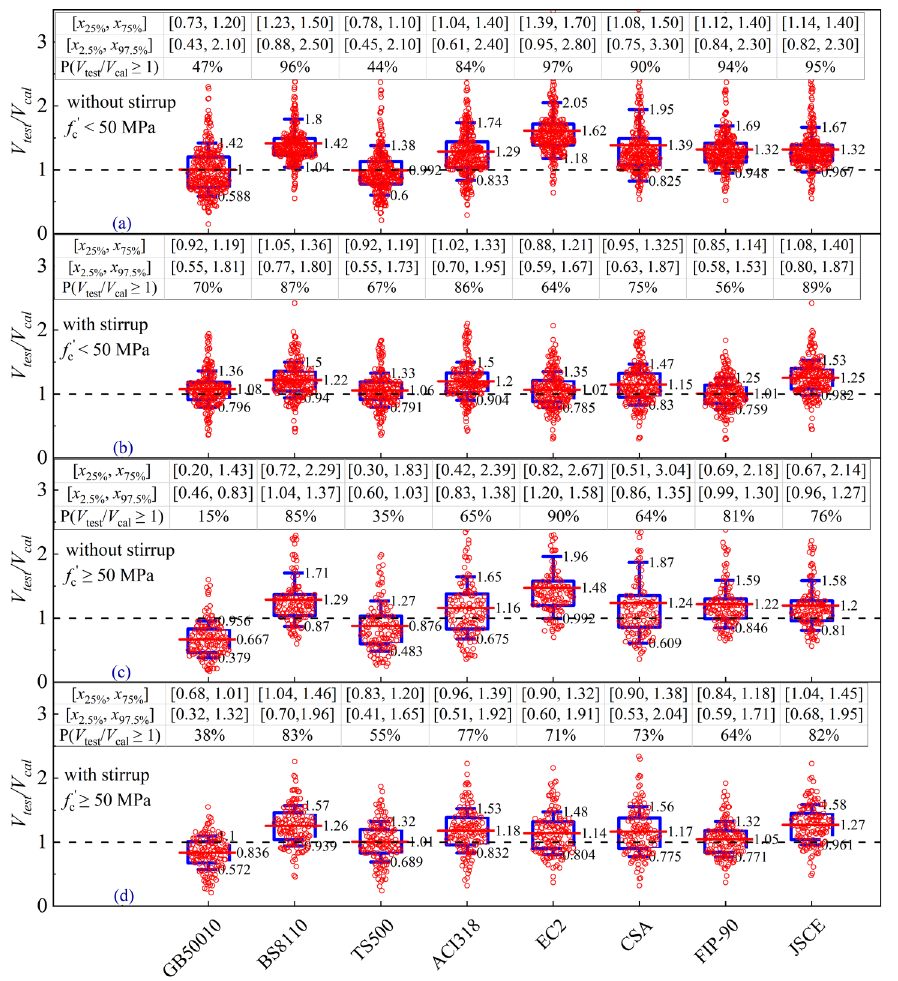
Figure 13. Codes: prediction results for beams without stirrup versus ( a ) normal concrete strength and ( c ) high concrete strength and for beams with stirrup versus ( b ) normal concrete strength and ( d ) high concrete strength.